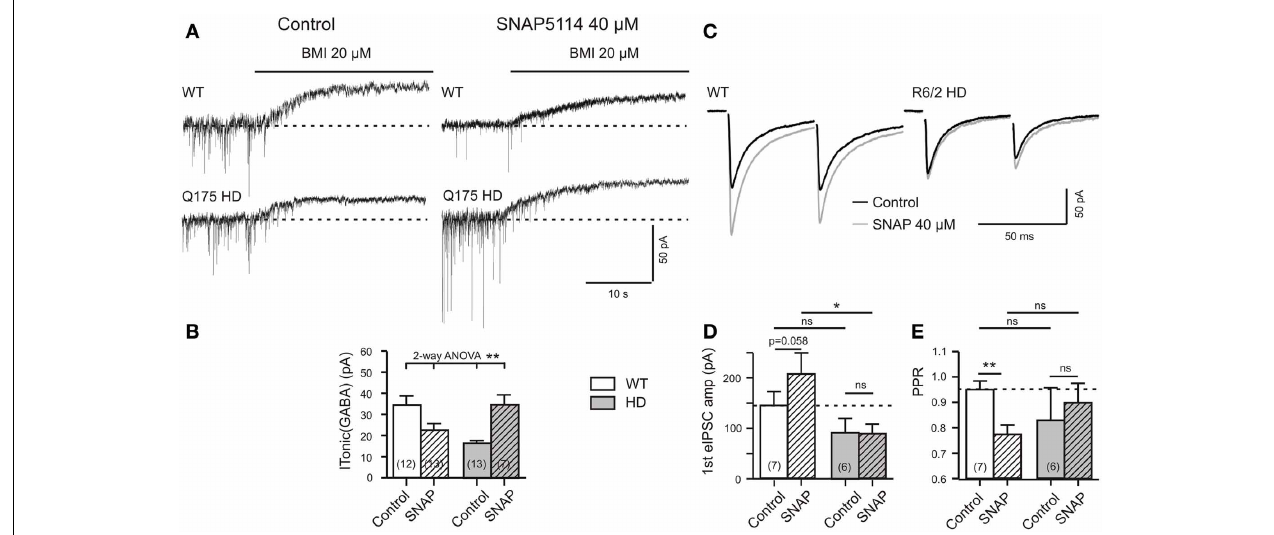
FIGURE 4 | HD-related differences in the effect of SNAP5114 on I Tonic ( GABA ) and presynaptic depression of evoked GABA release. (A) Sample traces of I Tonic ( GABA ) from a Q175 WT and HD SONs. Recordings in the presence of TTX (1 µ M), CGP (1 µ M), DNQX (10 µ M), APV (50 µ M), and LY341495 (40 µ M). Note opposite effects of GAT-3 block with SNAP5114 (40 µ M) in WT and HD. (B) Quantification of results from Q175 WT and HD. Significance level according to 2-Way ANOVA with subsequent Bonferroni correction for four comparisons. Normality was verified by the Kolmogorov–Smirnov test. The ANOVA table gave the following